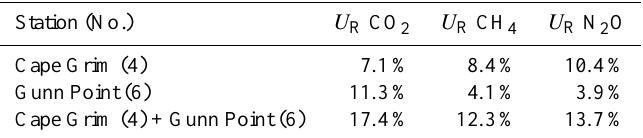
Table 3. Uncertainty reduction ( U R ) for the two existing stations in the base network in terms of their ability to reduce the uncertainties on CO 2 , CH 4 and N 2 O flux estimates. The station number is provided in brackets.